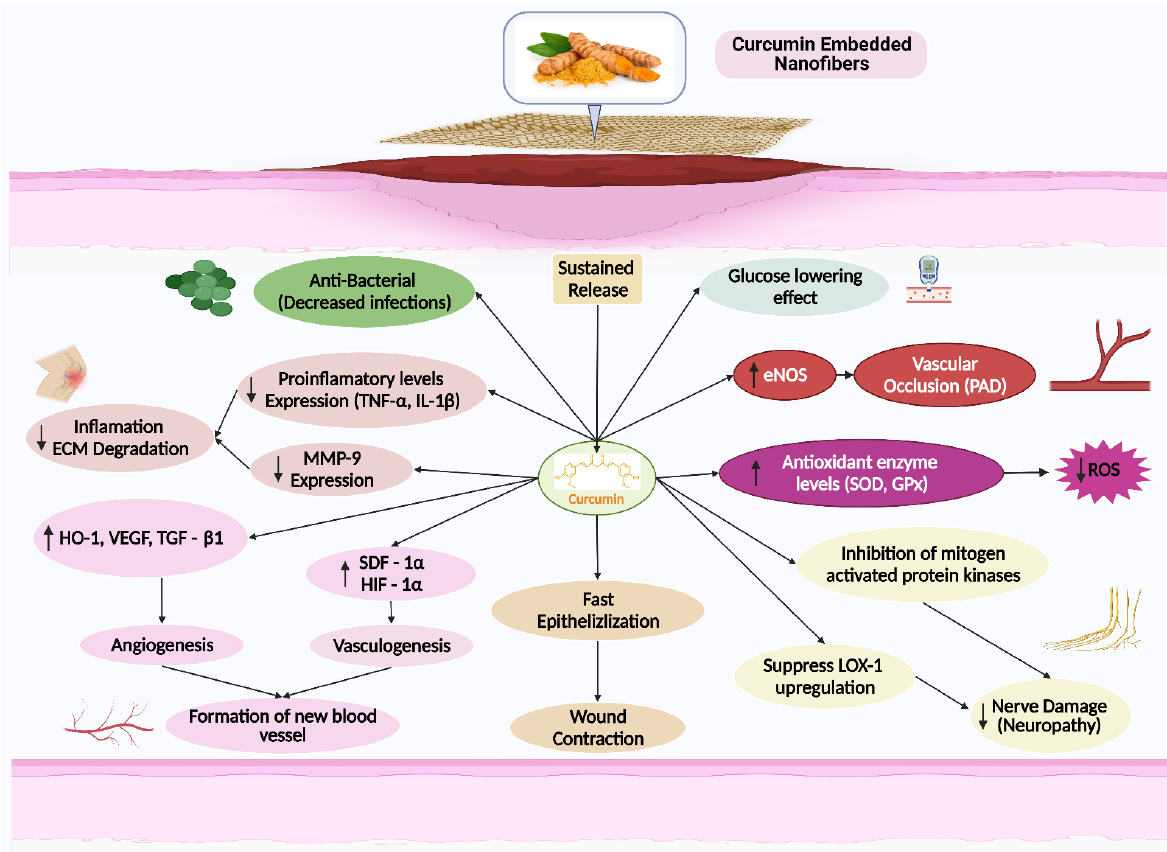
Figure 4. Curcumin mechanism of action in treating diabetic wounds ( ↑ : Increases, ↓ : decreases). Created with BioRender.com (accessed on 8 September 2022).